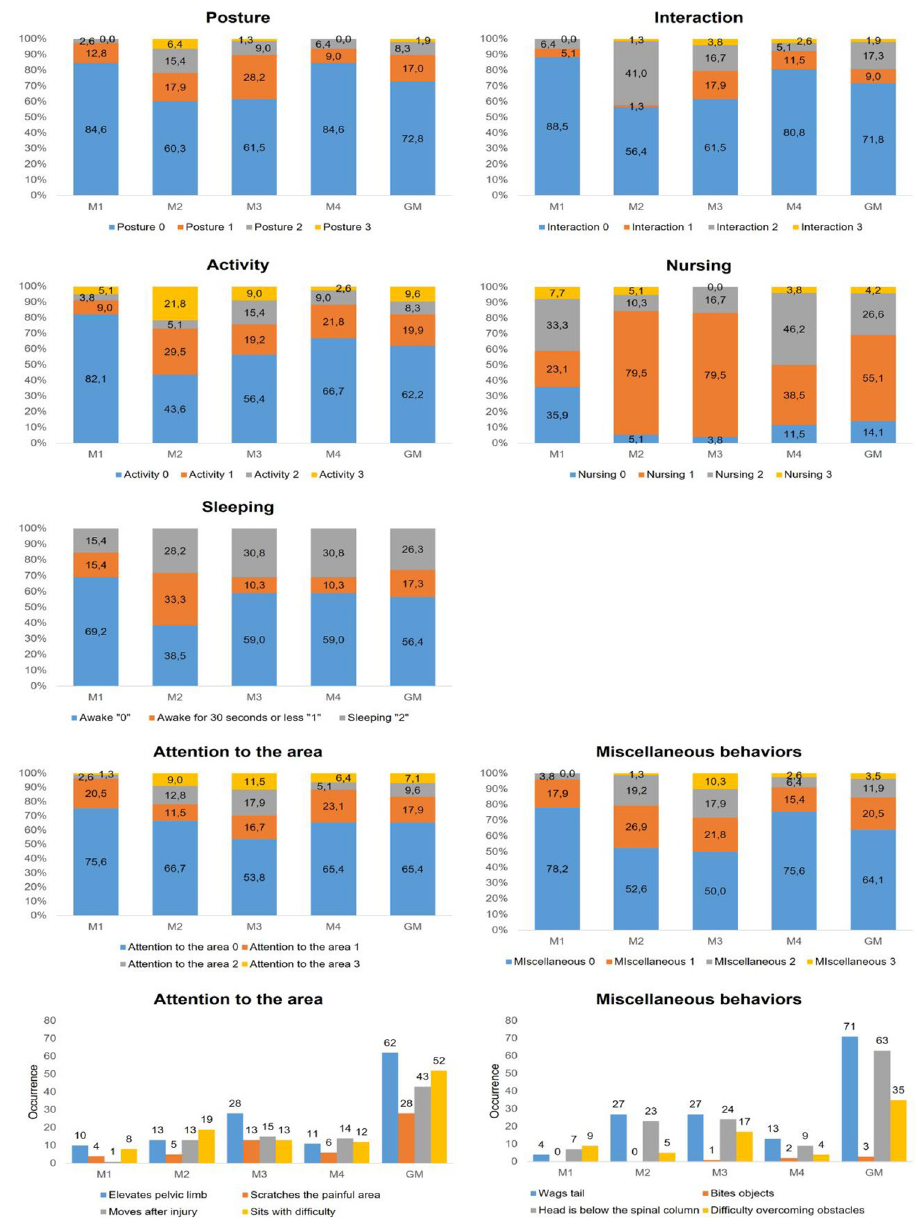
analgesia), M4 (24h post-procedure) GM—data of the grouped moments (M1 + M2 + M3 + M4).